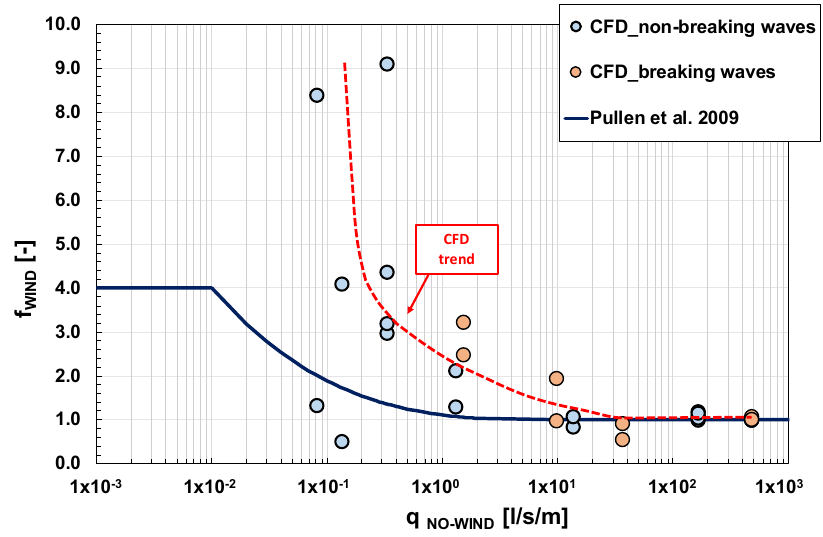
Figure 17. Comparison between numerical and physical f WIND trends [5].